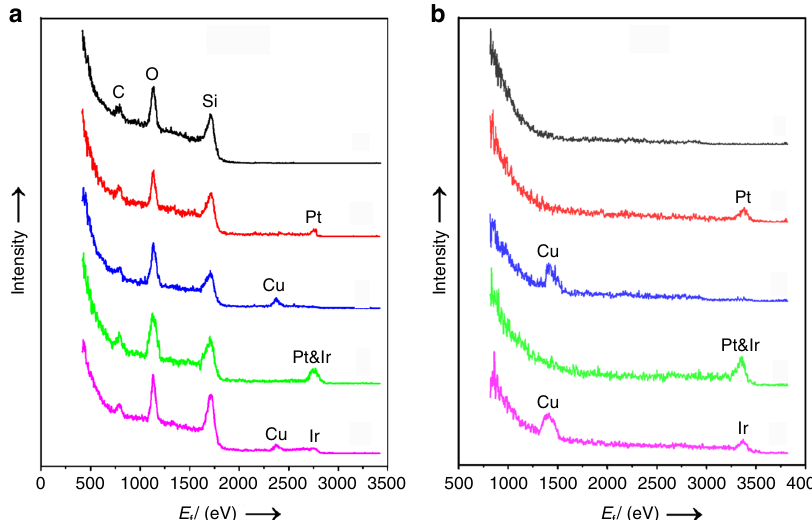
Fig. 3 The chemical composition on the outermost surface. HS-LEIS spectra using a 3 keV 4 He + and b 5 keV 20 Ne + for the samples: SiC (black), Pt/SiC (red), Cu 2 O – Pt/SiC (blue), Pt/SiC/IrO x (green) and Cu 2 O – Pt/SiC/IrO x (pink).